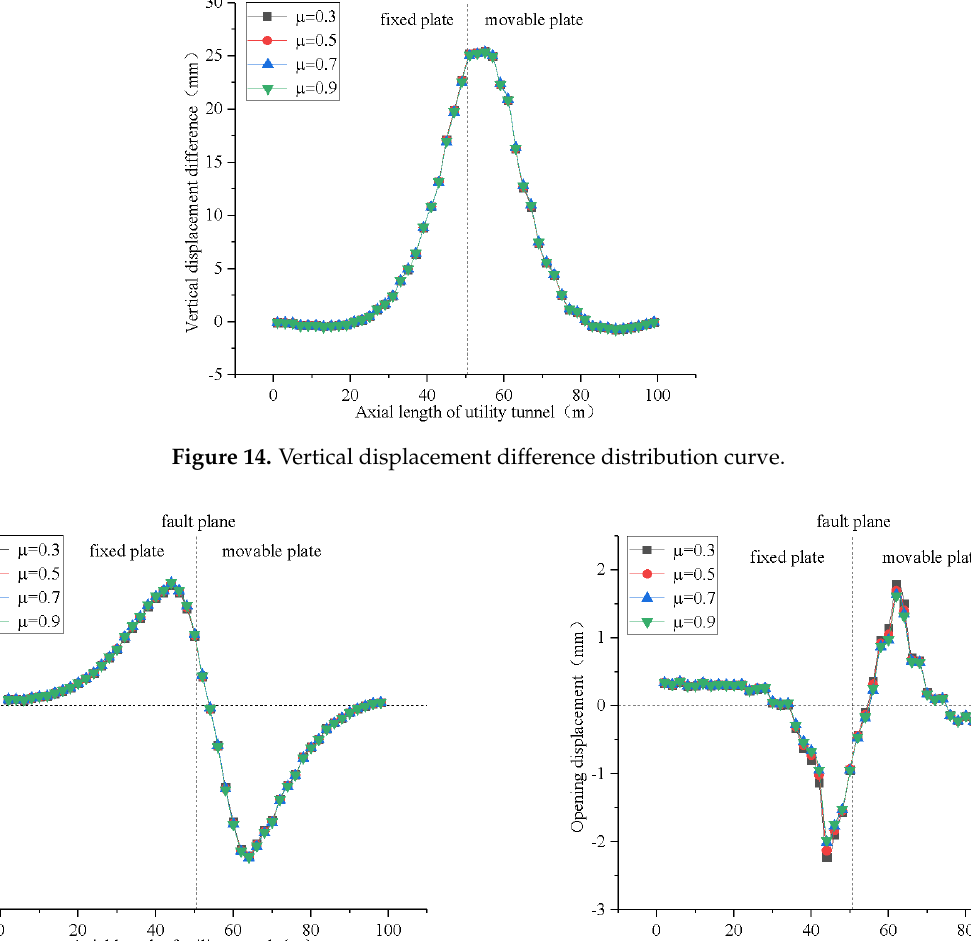
Figure 13. Vertical displacement distribution curve.